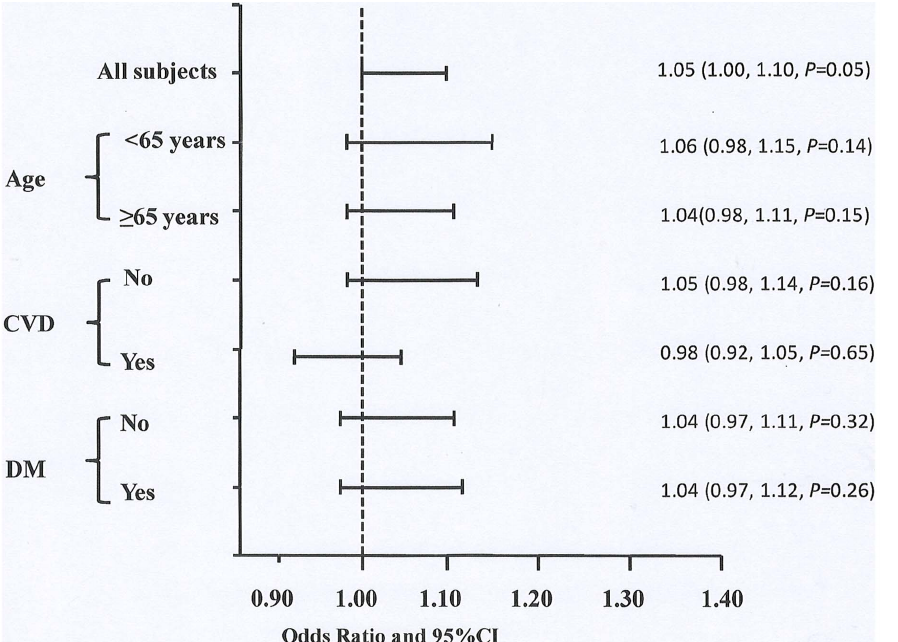
Figure 3. Risk of all-cause mortality in all subjects and subgroups. Subgroups were divided by age $ 65 years or , 65 years, with or without CVD or DM at baseline. All models are adjusted for age, gender and center size. Abbreviations: UA, uric acid; CDV, cardiovascular disease; DM, diabetes.